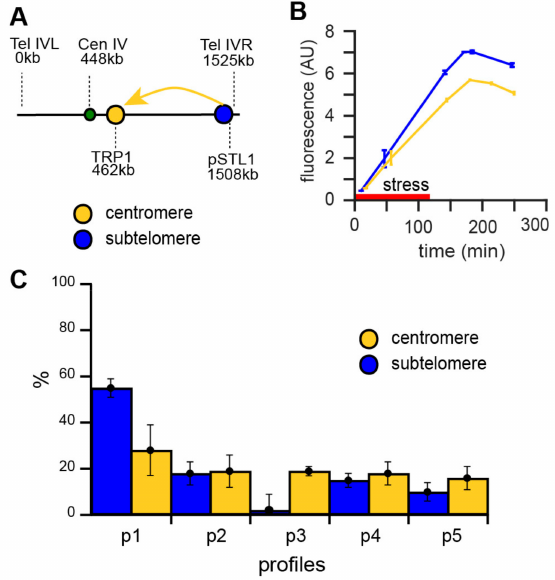
Figure 4. ( A ) Displacement of pSTL1 towards the peri-centromere of chromosome IV. Sketch of the endogenous genomic position of pSTL1 on chromosome IV. The promoter was moved to the TRP1 locus on the same chromosome. Genomic positions are indicated in Kb. ( B ) Reduced activity of displaced pSTL1 in response to stress. Fluorescence quantification of promoter activity in response to 2 h hyperosmotic stress (red bar) for the endogenous promoter (blue) and displaced promoter (yellow). Data are mean ± standard deviation of triplicate experiments. ( C ) Displacement of pSTL1 leads to loss of the memory e ff ect. Single-cell quantification of cells containing the displaced pSTL1 promoter in response to two hyperosmotic stresses. Response profiles were classified according to the five typical profiles in Figure